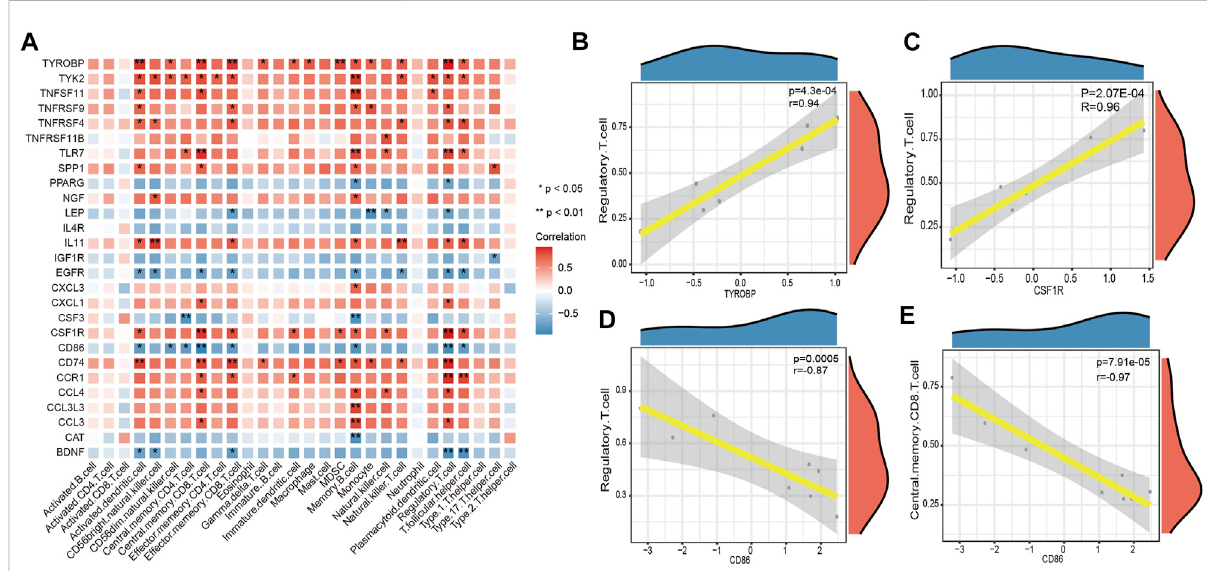
FIGURE 10 Immune cell in fifi ltration correlation analysis. (A) Heatmap showing the results of correlation analysis between the DEGs associated with LFH immunity and in fifi ltrated immune cells. The horizontal axis indicates the different immune cell types, and the vertical axis indicates the DEGs associated with LFH; the darker the color of the square, the stronger the correlation between the DEGs and the immune cell type; * indicates the difference is statistically signi fifi cant ( p < 0.05); (B, C) scatter plots of the top 2 positively correlated gene pairs with immune cells. (D, E) scatter plots of the top 2 negatively correlated gene pairs with immune cells. Horizontal coordinates indicate the DEG expression levels and vertical coordinates the ssGSEA enrichment scores of immune cell types.